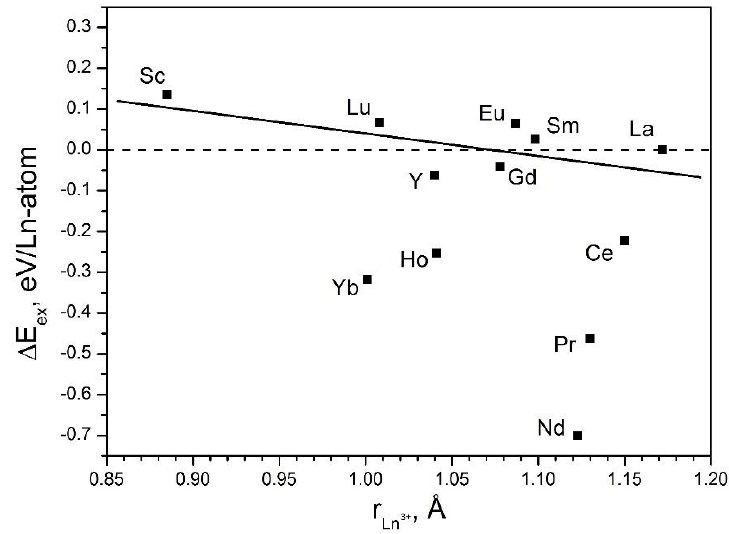
Figure 7. The energy ∆ E ex estimated using density functional theory (DFT) method for the exchange (5 at %) of a Ln cation between the bulk of LaS and the slab of LaS within (LaS) 1.11 TaS 2 misfit compound, as a function of the Ln 3 + cation radius r. Negative value ∆ E ex signifies favorable environment for the Ln dopant within the quaternary misfit lattice. The full curve indicates a trend in the variation of ∆ E ex as a function of the steric factor alone. However, several Ln cations with open electronic shell, which are stronger electron acceptors, like Nd, Pr etc., show negative ∆ E ex (courtesy of Dr. A. Enyashin).